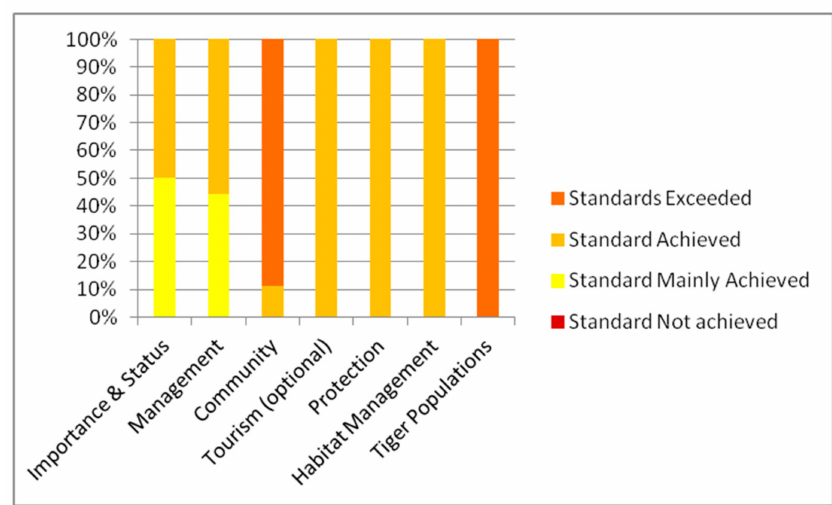
Figure 4. Overview of conformity of the 17 elements under seven pillars of CA|TS (see Figure 2) of CA|TS for Chitwan National